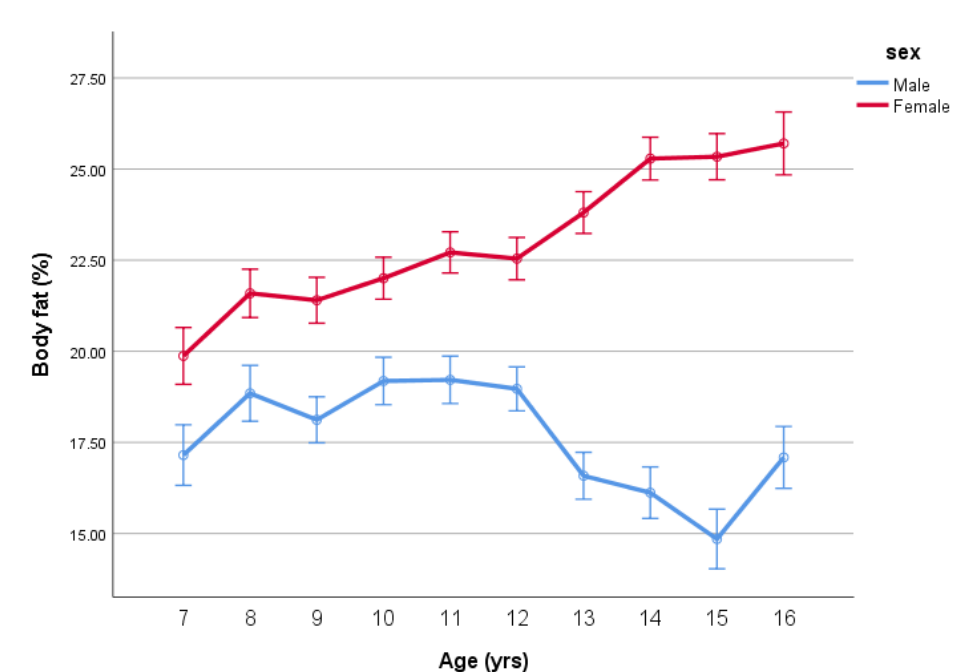
Figure 1. Mean BMI (mean ± SE) by age and sex.